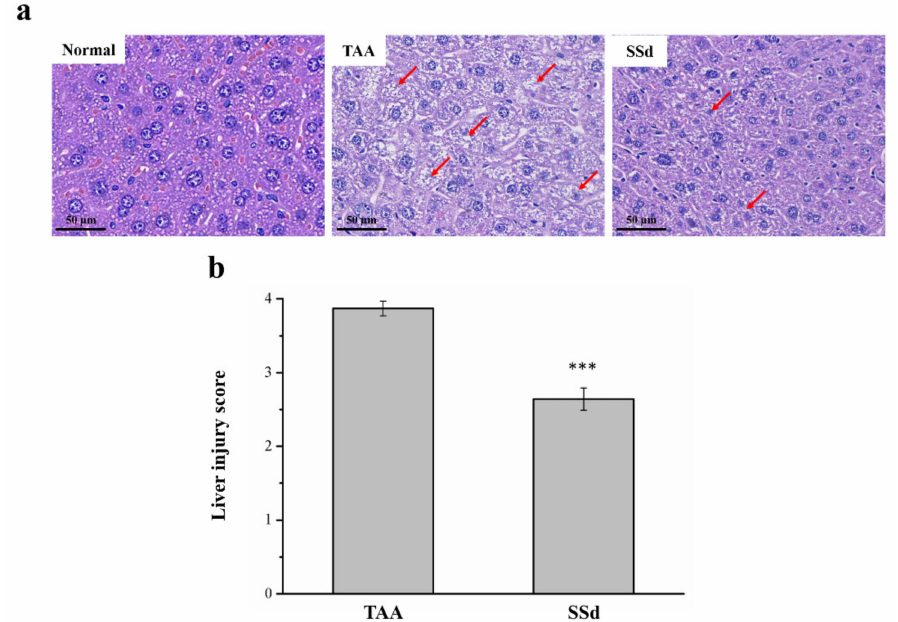
Figure 3. Changes in ( a ) liver histology by H&E staining (magnification 200 × ) and ( b ) scoring index of liver injury in the control, TAA, and SSd groups over 8 weeks. Anormal hepatocytes are indicated by red arrows. All data for are reported as means ± SD (n = 8). *** p < 0.001 was considered statistically significant. H&E, hematoxylin and